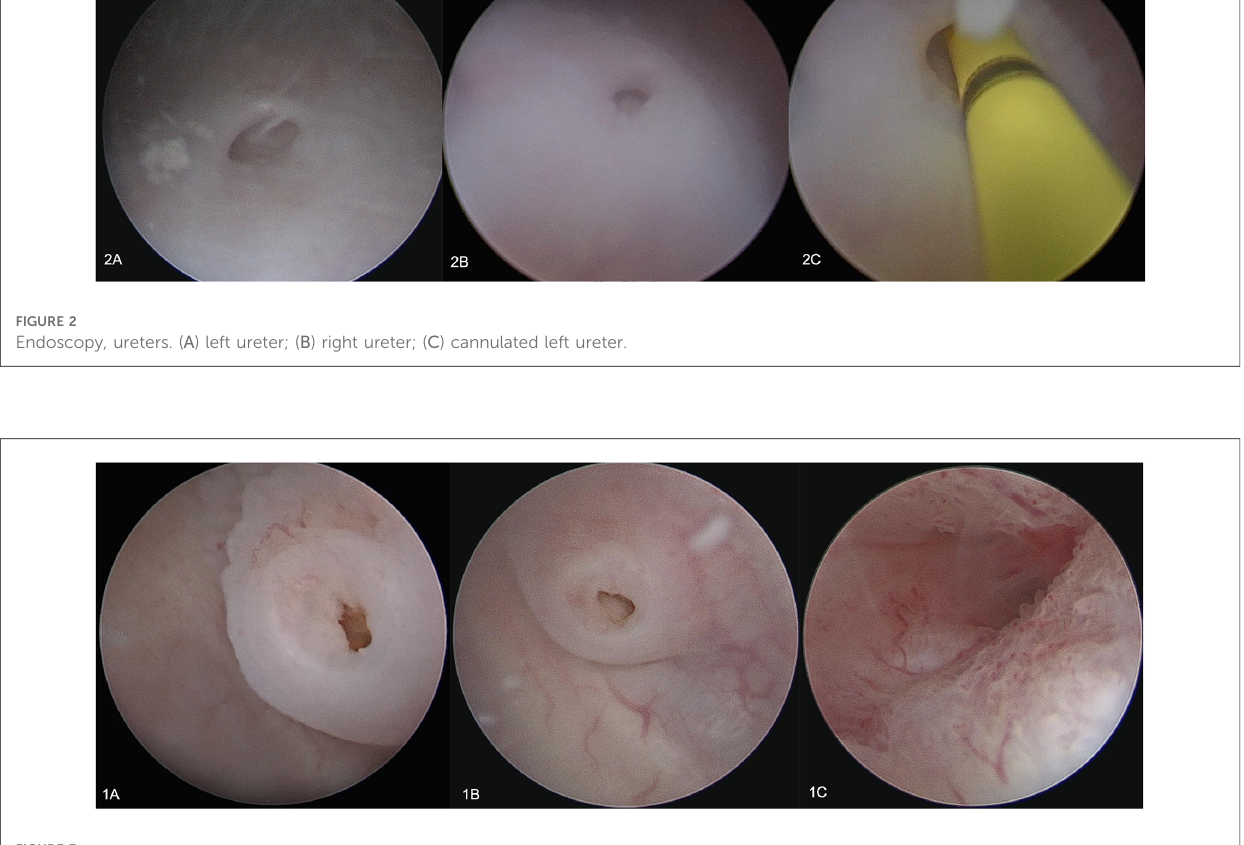
FIGURE 3 Endoscopy. ( A ) left vaginal ostia on the PUGS lateral-posterior wall; ( B ) right vaginal ostia on the PUGS on the lateral posterior-wall; ( C ) left